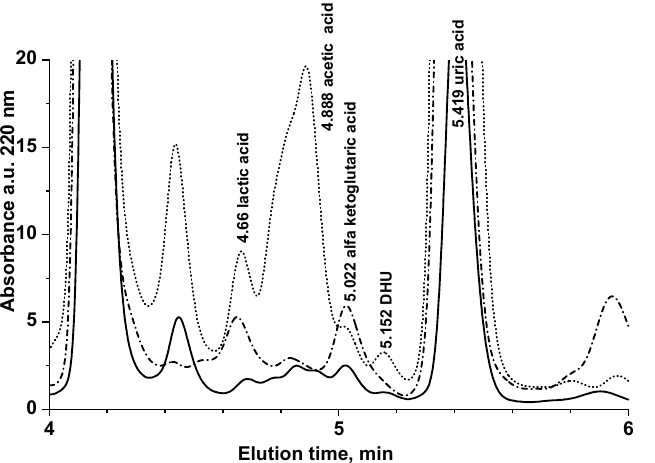
Figure 2. Representative absorbance chromatogram at 220 nm of saliva samples of S20 (dotted line, 0.66 ± 0.67 µ mol L − 1 DHU, N = 3 sampling in different days) and S21 (continuous line, 0.19 ± 0.14 μ mol L − 1 DHU, N = 4 sampling in different days) compared with the chromatogram of a nominally healthy volunteer with DHU < LOQ (S18, dash-dotted line).